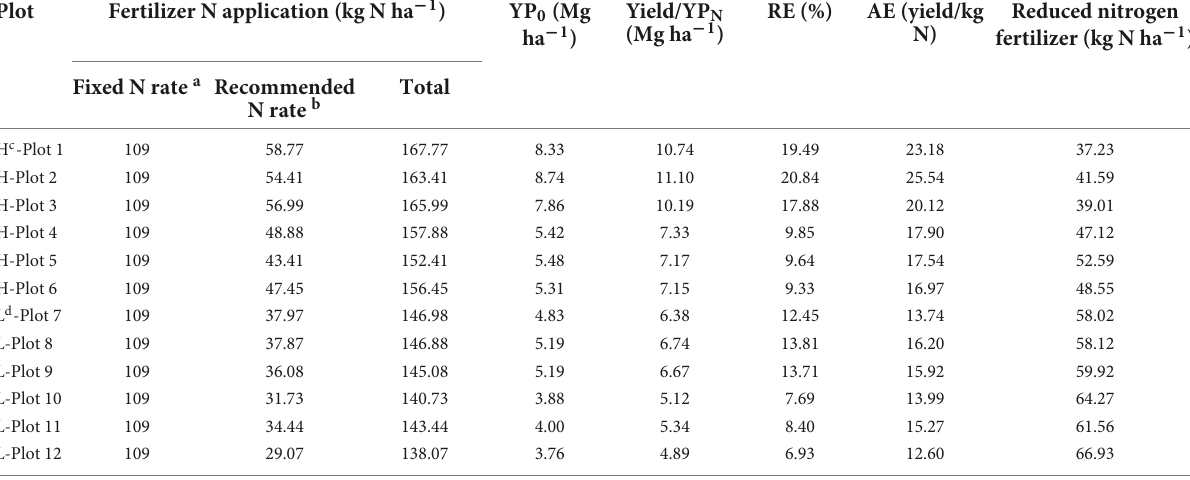
TABLE 5 Estimation of sensor-based topdressing N amounts at different densities using the experimental data for bok choy.